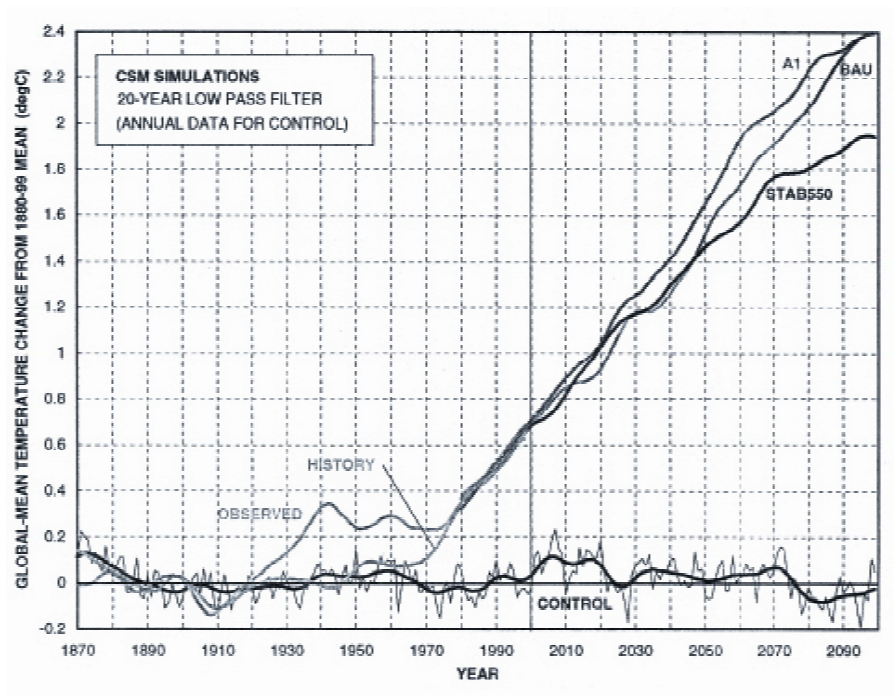
FIGURE 28. Global temperature predicted by the model for two scenarios, BAU and